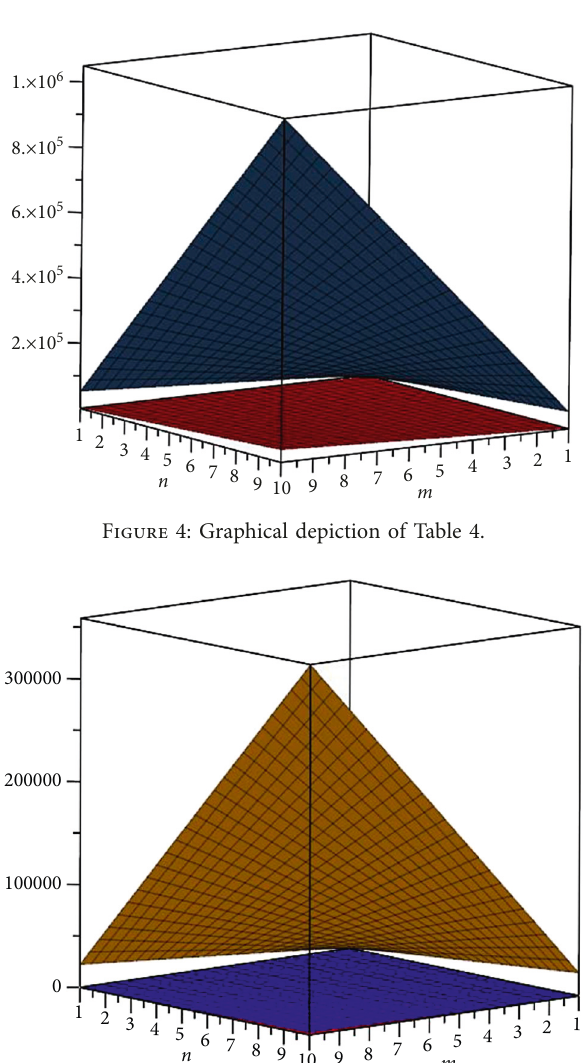
Figure 5: Graphical depiction of Table 5.